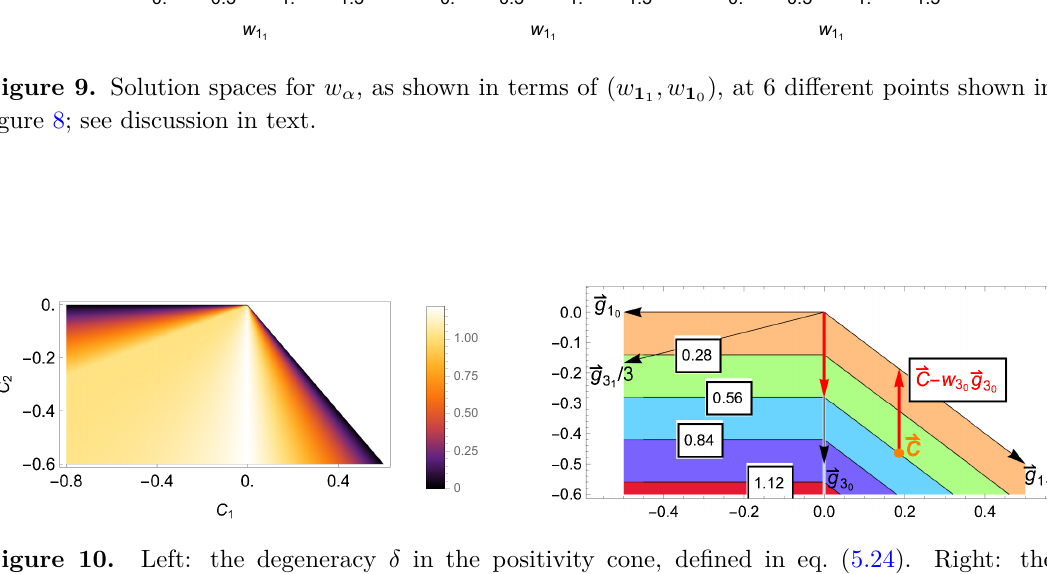
) , at 6 different points shown in , w 1 1 0